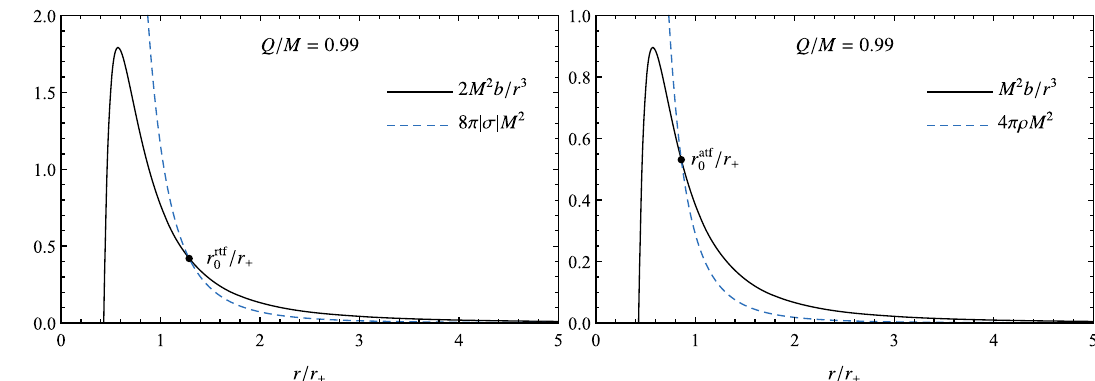
black disks denote the points in which the corresponding tidal force vanishes. Note that for this value of the BH charge, the radial tidal force vanishes outside the event